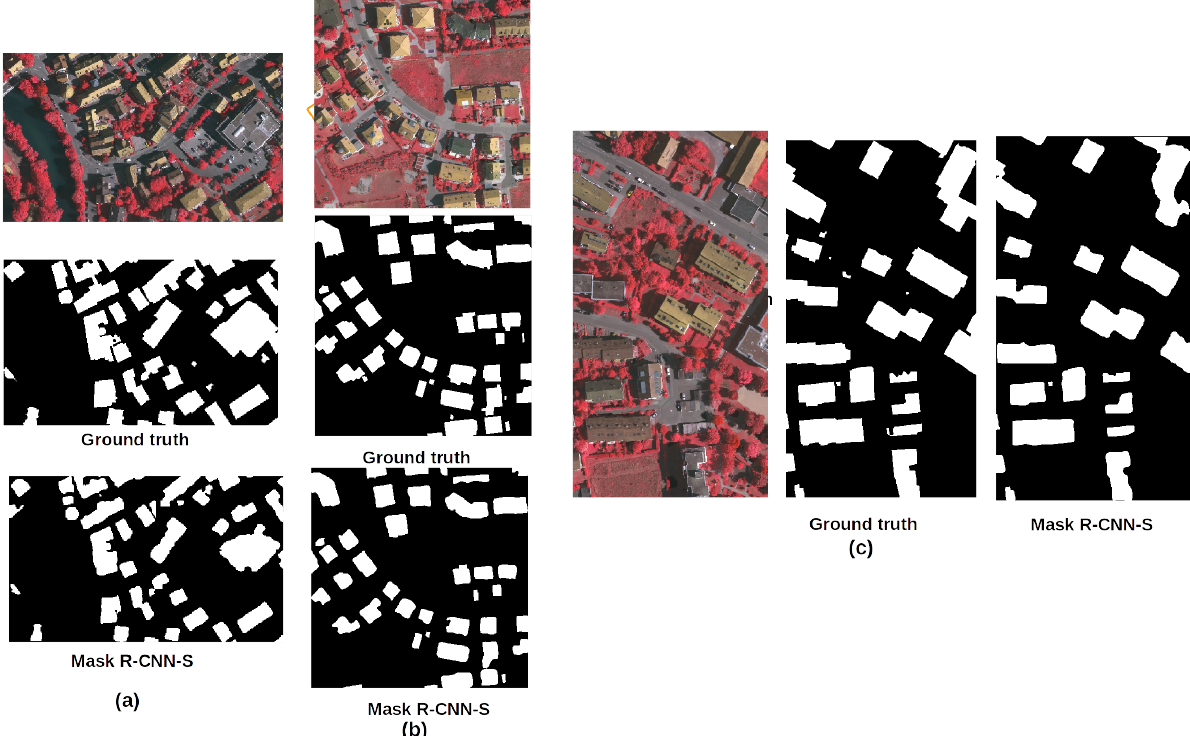
Figure 2. The building segmentation results of Mask R-CNN-S for test dataset with small anchor scale of [16 2 − 256 2 ] .